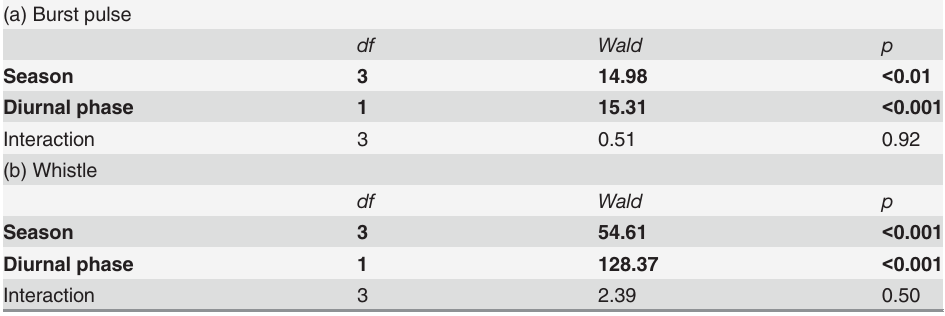
Table 1. Results of the factorial ANOVA for seasonal and diurnal effects on the detected duration of (a) burst pulses and (b)